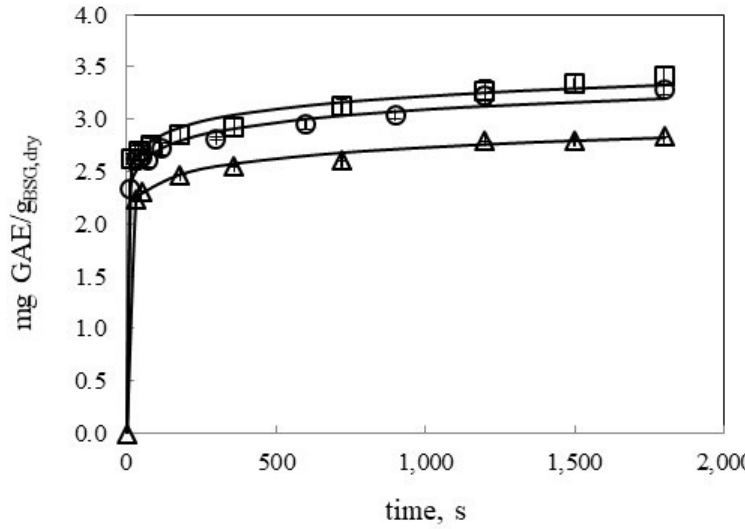
Figure 4. E ff ect of temperature on TPC water extraction kinetics by UAE ( ∆ 39 ◦ C, Figure 4. Effect of temperature on TPC water extraction kinetics by UAE (Δ 39 °C, ○ 47 °C; □ 58 °C) at a 21.7 mL: g BSG,dry ratio. Continuous lines represent the Weibull a 21.7 mL: g BSG,dry ratio. Continuous lines represent the Weibull model.